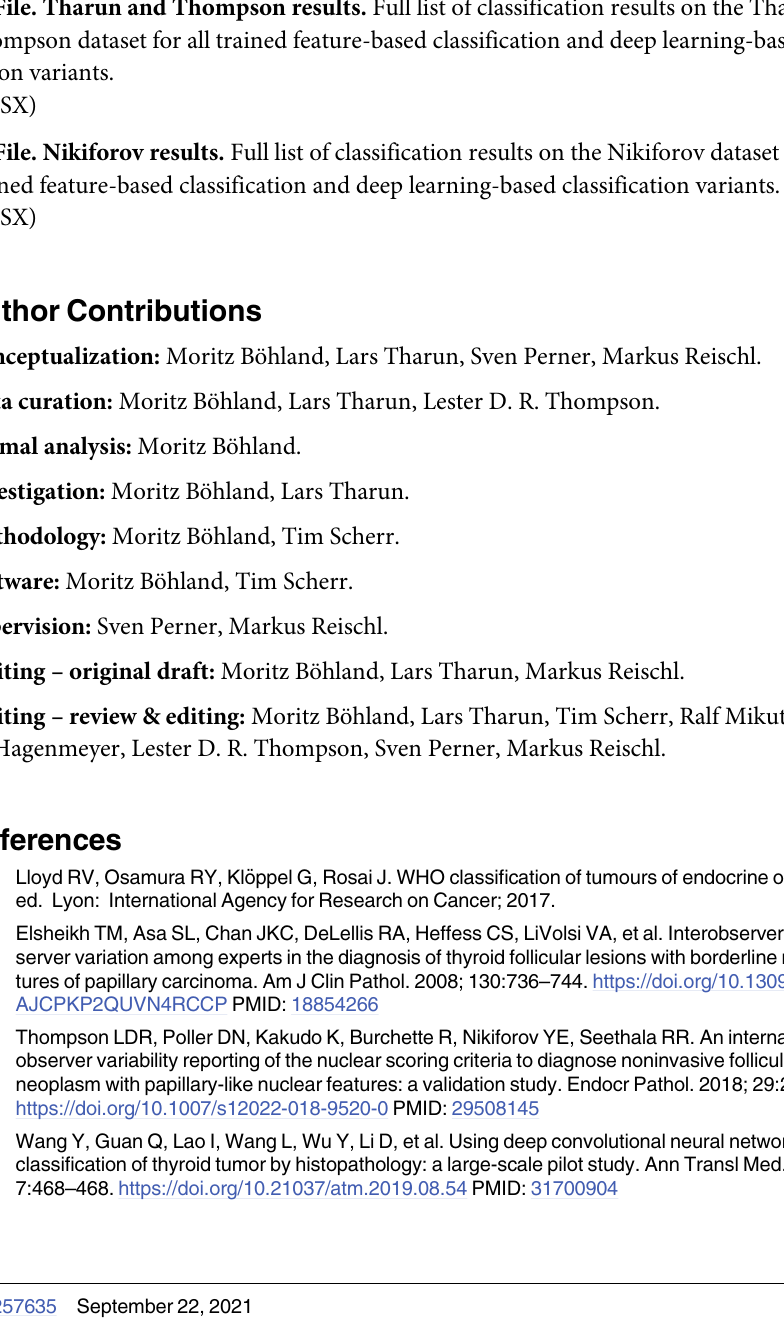
S1 Fig. Example images. Example images from the Nikiforov dataset and the Tharun and Thompson dataset from both classes PTC-like and non-PTC-like. S1 File. Tharun and Thompson results. Full list of classification results on the Tharun and Thompson dataset for all trained feature-based classification and deep learning-based classifi- cation variants. S2 File. Nikiforov results. Full list of classification results on the Nikiforov dataset for all trained feature-based classification and deep learning-based classification